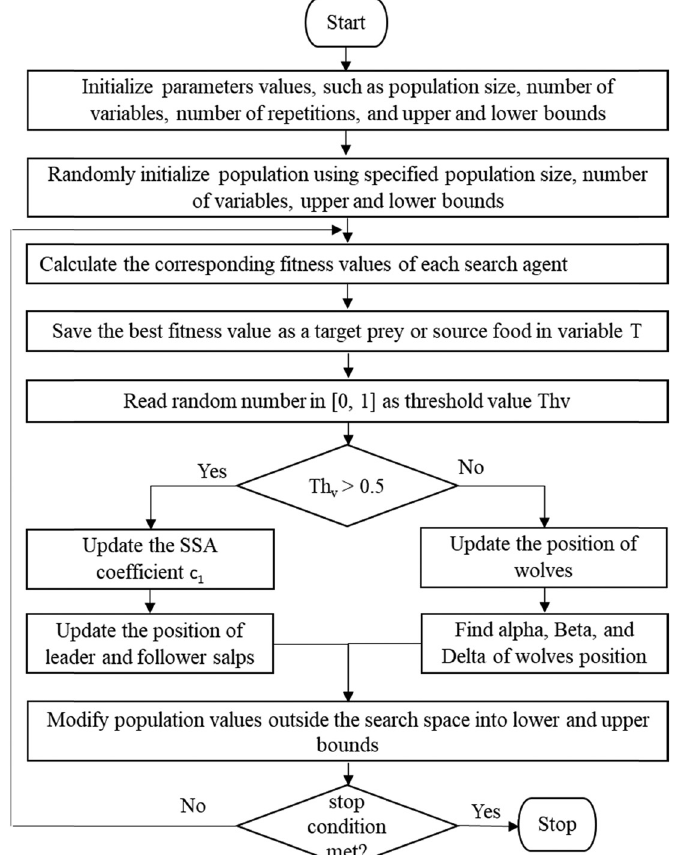
Figure 5: Flowchart for the suggested hybrid SSA – GWO